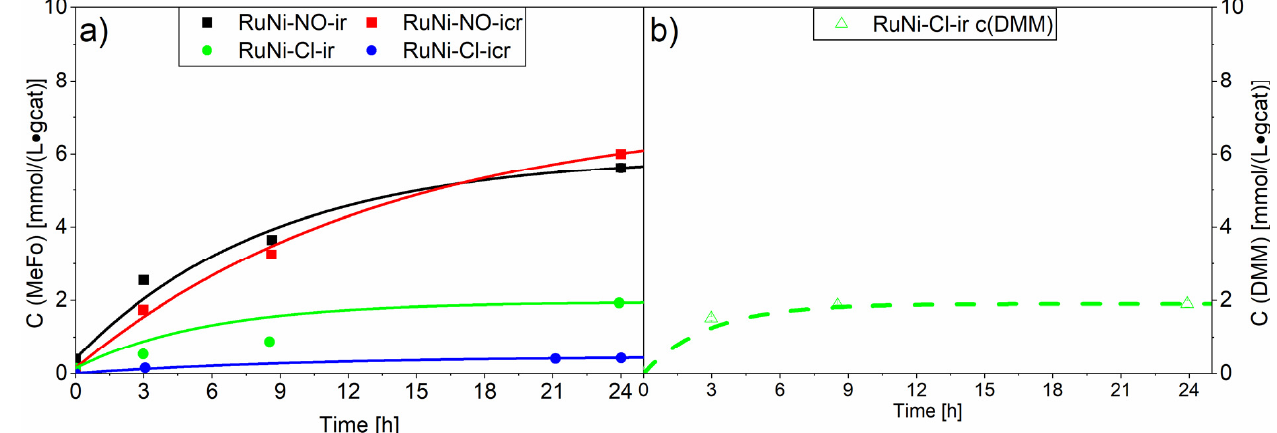
Figure 8. Results of screening experiments with the ruthenium-nickel on Al 2 O 3 catalyst. The compact line shows the concentration for methylformate ( a ) and the dashed line shows the concentration of dimethoxymethane. ( b ) The concentrations generated with RuNi-NO catalysts are marked with squares whereas the concentrations generated with RuNi-Cl catalysts are marked with circles.